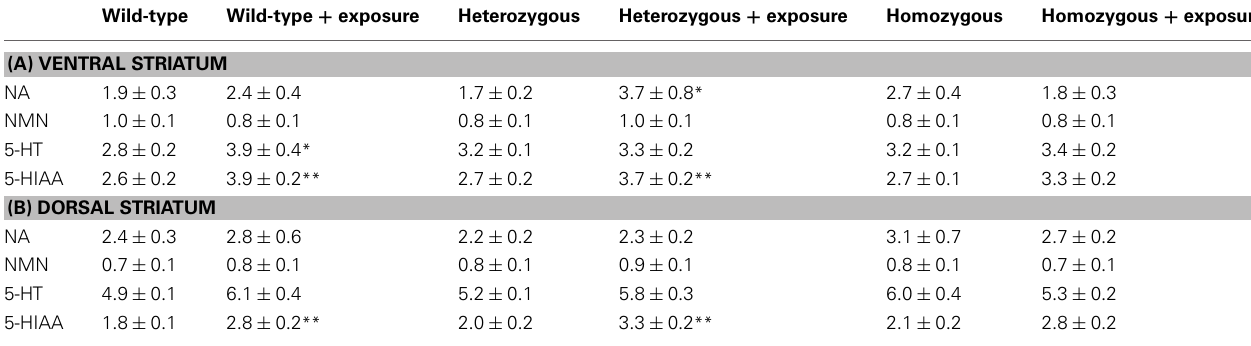
Table 2 | Effect of exposure of Wfs1-deficient mice to the motility boxes on the levels of monoamines and their metabolism in the ventral and dorsal